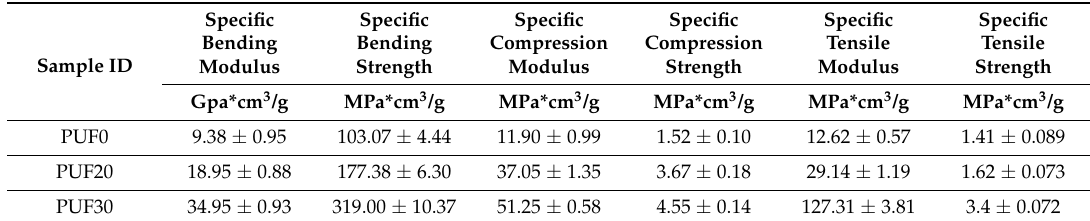
Table 3. Specific mechanical properties of PUF.